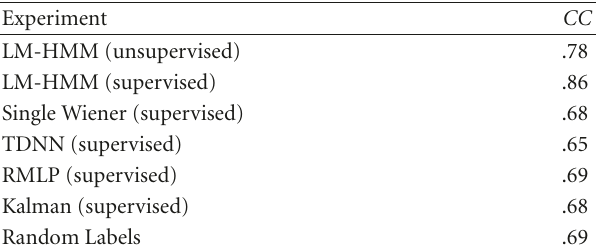
Table 2: Correlation coe ffi cient using LM-HMM on 3D monkey